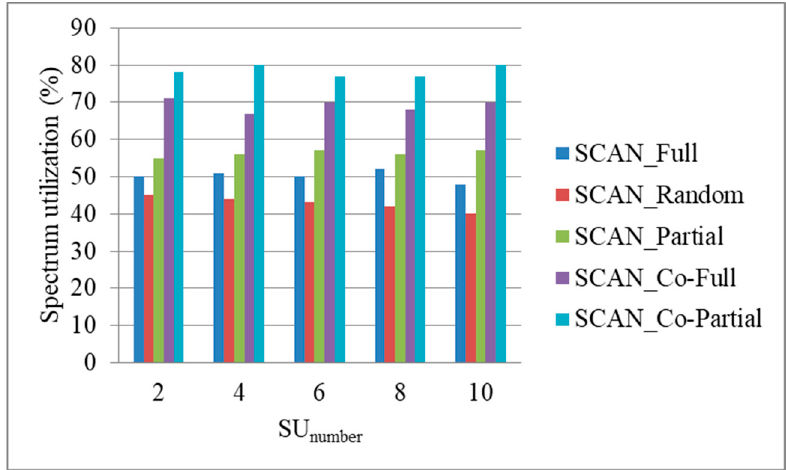
Figure 13. Spectrum utilization ratio under different number of SU cars (PU number = 10, P PUaccess = 0.5, V = 10).